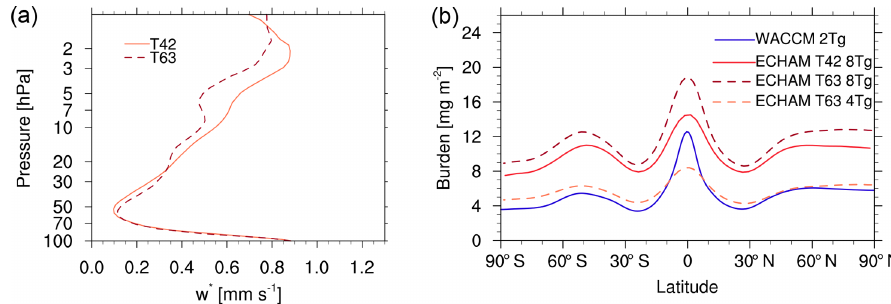
Figure 13. (a) Residual vertical velocity in the tropics of control simulations of ECHAM with T42 and T63 resolution. (b) Zonally averaged sulfate burden of WACCM (blue) and ECHAM T63 (dashed) and T42 (solid).